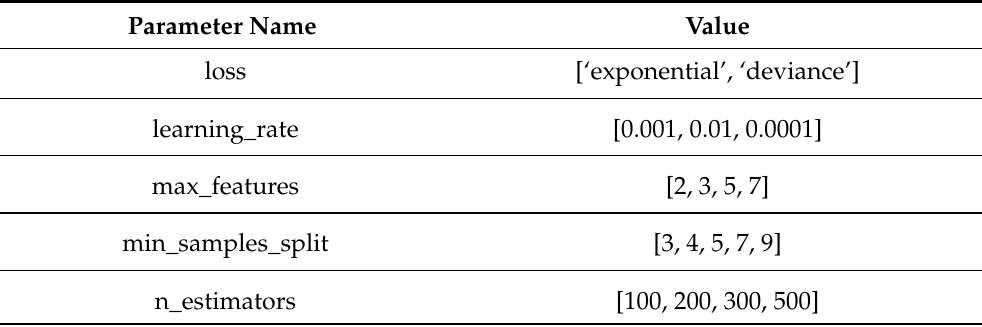
Figure 4. Visualisation of gradient boosting algorithm. Table 6. Gradient boosting hyperparameter.